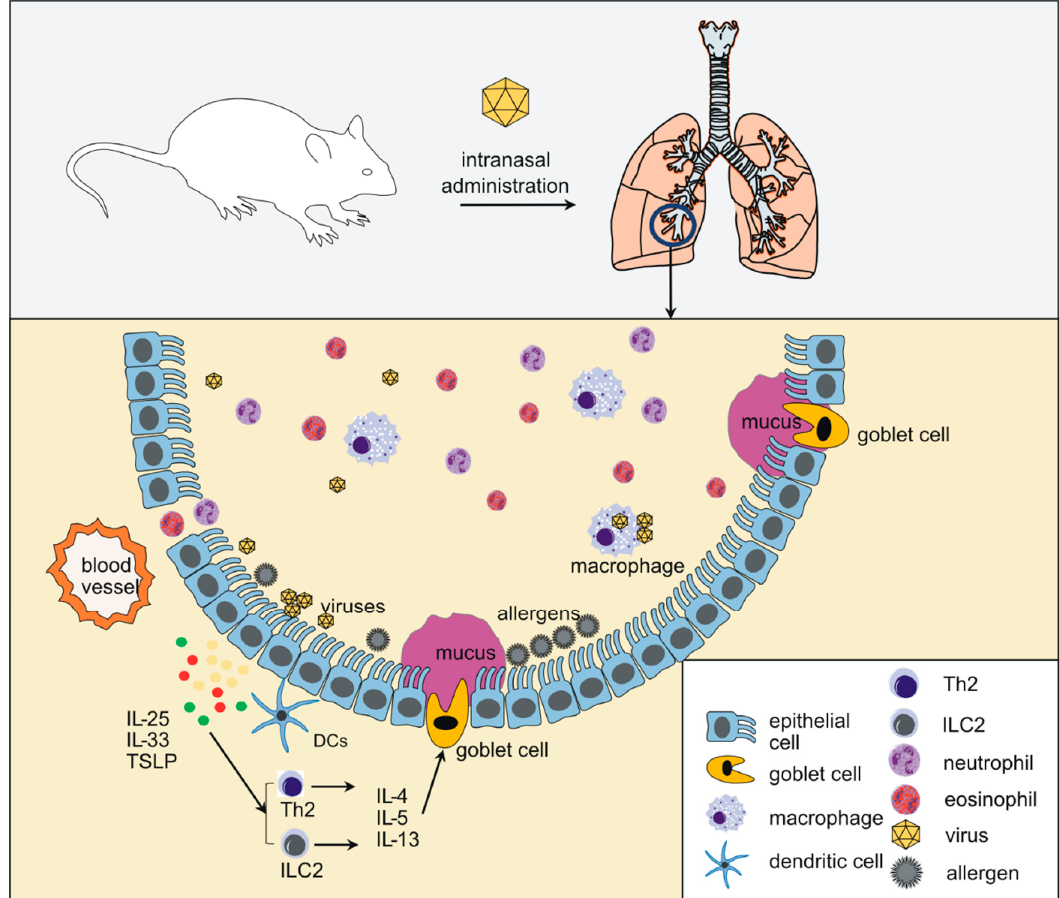
Figure 2. Array of airway cells involved in the response to viral infection. Viruses replicate in the airway epithelium and epithelial cells secrete chemokines which attract innate immune cells to the airway. The airway epithelium also includes resident dendritic cells that respond to allergens, pathogens and damage signals. Among the other innate immune cells shown to be activated after viral infection are exudative macrophages (also called inflammatory monocytes) and innate lymphoid cells. Epithelial-derived innate cytokines (IL-25, IL-33 and TSLP) play a special role as they may activate type 2 helper T (Th2) cells and type 2 innate lymphoid cells (ILC2s) which elaborate type 2 cytokines (IL-4, IL-5 and IL-13) leading to mucous metaplasia. Thus, under certain circumstances, initiation of type 2 inflammation by viruses may not require allergen exposure.